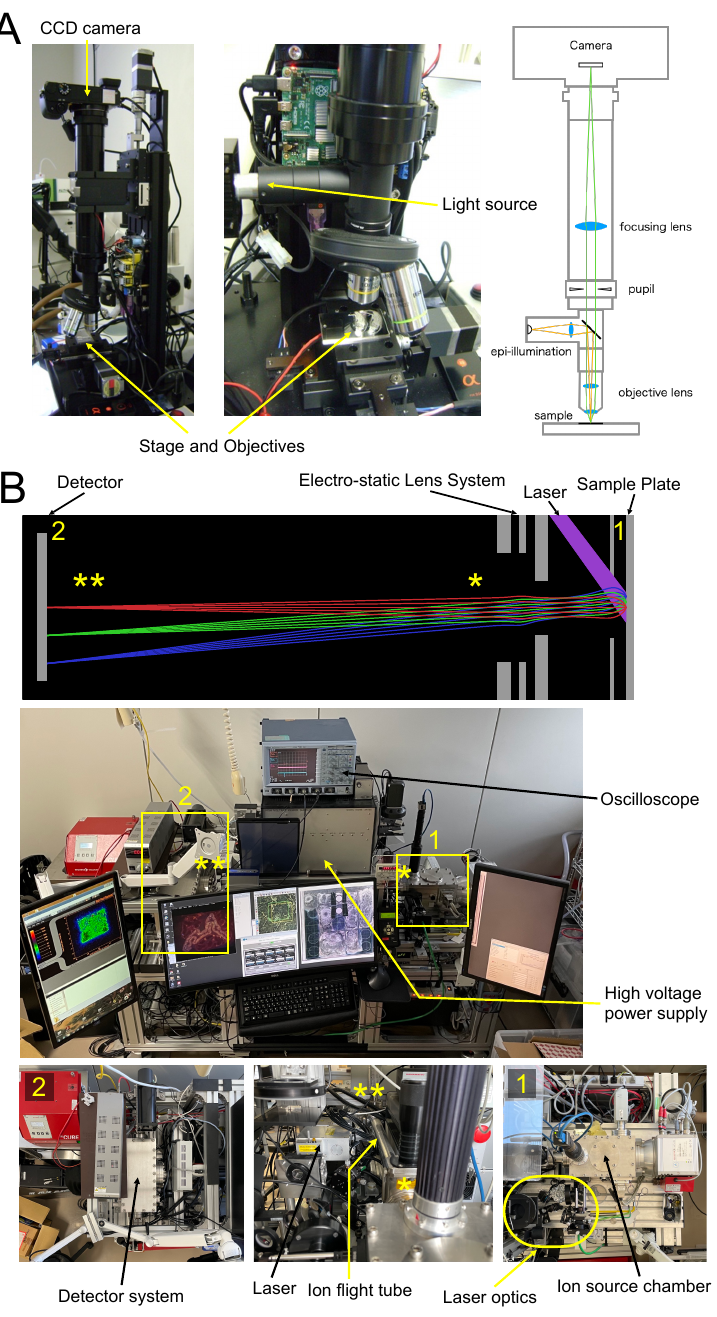
Figure 1. Optical microscope system and STCM IMS. ( A ) Bright-field epi-illumination microscope and CCD imaging system (ILCE-6000, Sony, Tokyo, Japan) for viewing unstained specimens (8 µm thick) mounted on a metal plate with magnifications of 10 × and 20 × (PLN10X and PLN20X, Olympus, Tokyo, Japan). Lens assemblies and the light path are shown on the right. ( B ) Equipment for STCM IMS. The laser path and the flight trajectories of ions are depicted schematically on top. The whole view of the instrument is photographed in the middle. The sample plate is placed inside the ion source chamber shown in Box 1. The detail of Box 1 is photographed in Picture #1 ( bottom right ). The electrostatic lens system is a part of the optics for the ion extraction system and is furnished in the same section in Box 1. The flight tube and high voltage power supply are photographed in the whole view picture and detailed in the photograph at the bottom center. Dissociated ions fly inside a meter-long ion flight tube from one end (one yellow asterisk) to the opposite end (two yellow asterisks). The detector system is enclosed in Box 2 and presented in detail in Picture #2 at the bottom left